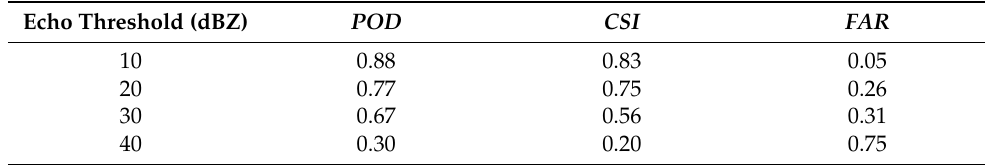
Table 7. Deep learning algorithm extrapolation results at 0.5 h.